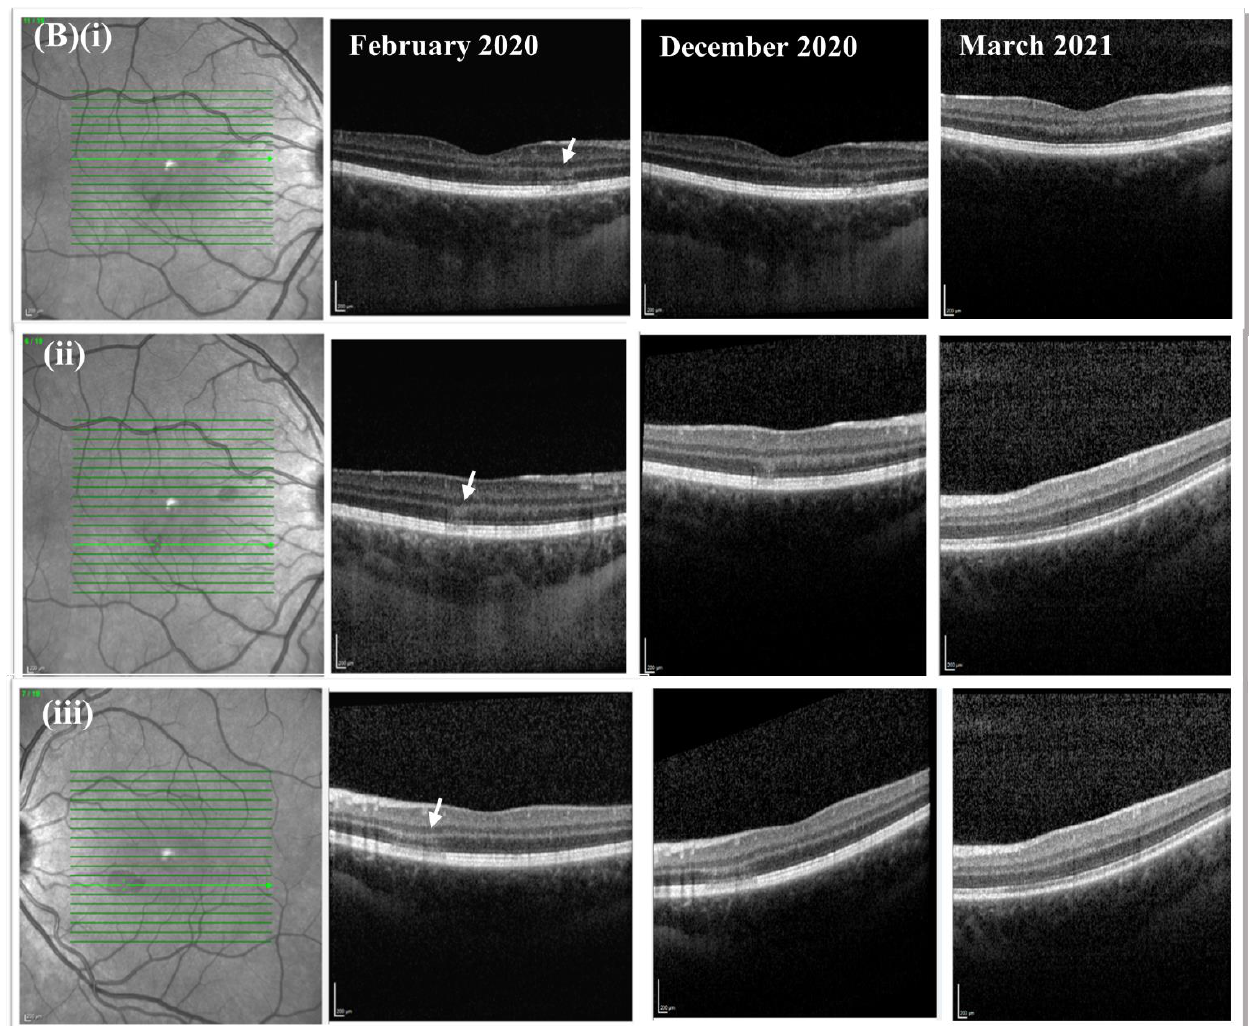
Figure 1. Near-infrared reflectance images from February 2020, and SD-OCT images from February 2020, December 2020, and March 2021. ( A ) Near-infrared reflectance images taken at presentation (February 2020) showing three discrete hyporeflective perifoveal lesions in the right eye and one in the left eye (white arrows). ( B ) Sequence over time of corresponding SD-OCT images through the two larger lesions in the right eye ( i , ii ) and the lesion in the left eye ( iii ), initially showing hyperreflectivity in the ONL and OPL with loss of clarity in the outer retinal bands (white arrows). This hyperreflectivity is seen to resolve over a 13-month period accompanied by improvement in the clarity of the outer retinal band architecture.